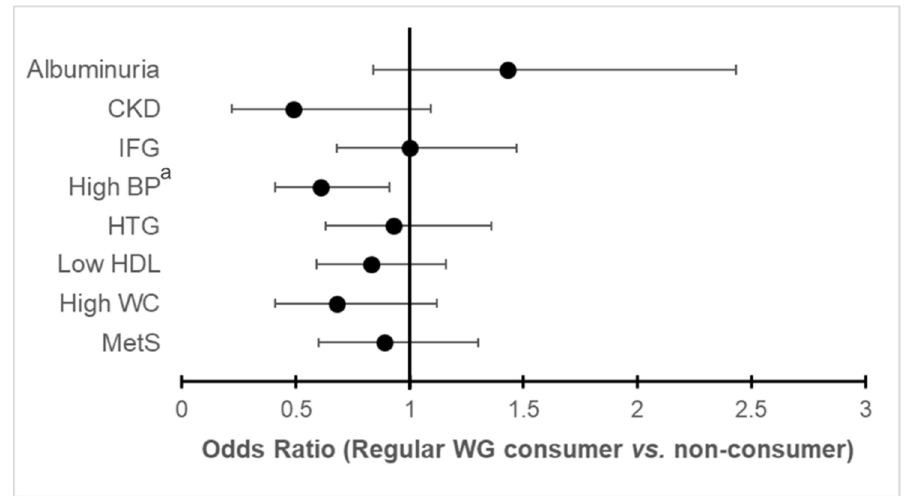
Figure 2. Odds ratio for regular wholegrain consumers ( n : 3,124,834) vs. non-consumers ( n : 6,369,362) on cardiorenal metabolic outcomes. MetS, metabolic syndrome; WC, waist circumference; HDL, high density lipoprotein; HTG, hypertriglyceridemia; BP, blood pressure; IFG, impaired fasting glucose; CKD, chronic kidney disease. a p < 0.05. Model was adjusted for geographical area, age, sex, BMI, education level, tobacco use, frequency of alcohol consumption and quantity of glasses of alcohol typically consumed, physical activity, diabetes, previous cardiovascular disease and consumption of fruits, vegetables and legumes. For renal outcomes (CKD and albuminuria) the model also included hypertension. Albuminuria was available in 2,159,174 regular WG consumers (70%) and in 4,499,396 non-consumers (71%) and ordinal regression instead of logistic regression was used.